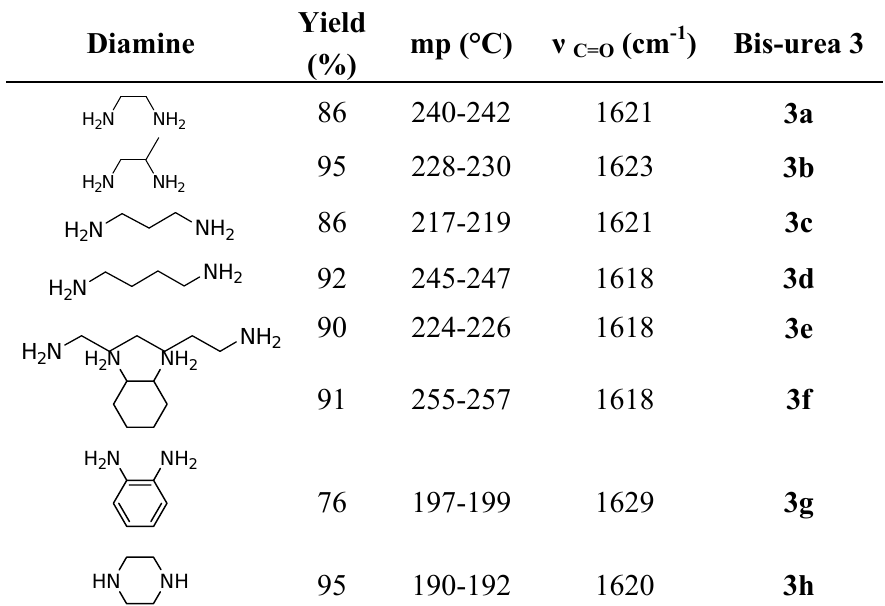
Table 1 . Preparation of bis-ureas from different